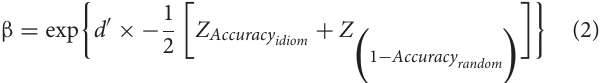
FIGURE 2 | Accuracy (including hits for frequent and infrequent idioms, and correct rejection for random and perceptual control) for younger and older adults in the idiom judgment task across four conditions. Error bars represent one standard error of the mean. Note that the standard error of older adults’ perceptual control was zero. ∗∗ denotes p < 0.01, and ∗ denotes p <